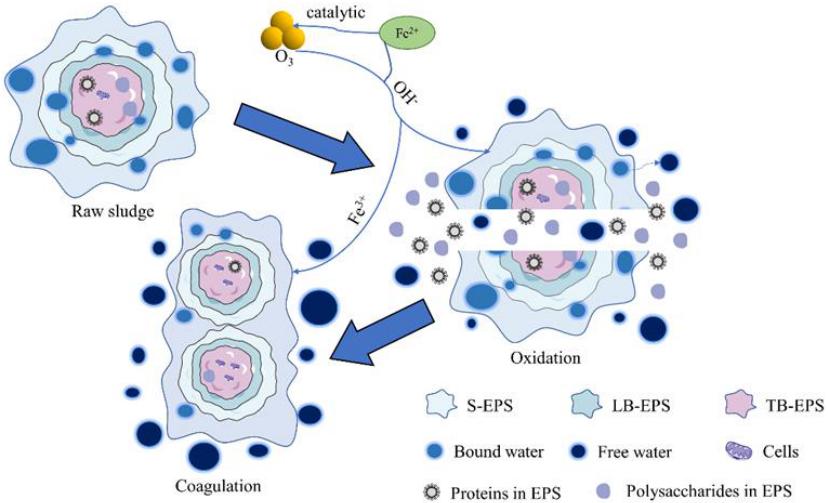
Figure 7. O 3 Two-step conditioning mechanism for oxidation and coagulation in conditioned sludge.